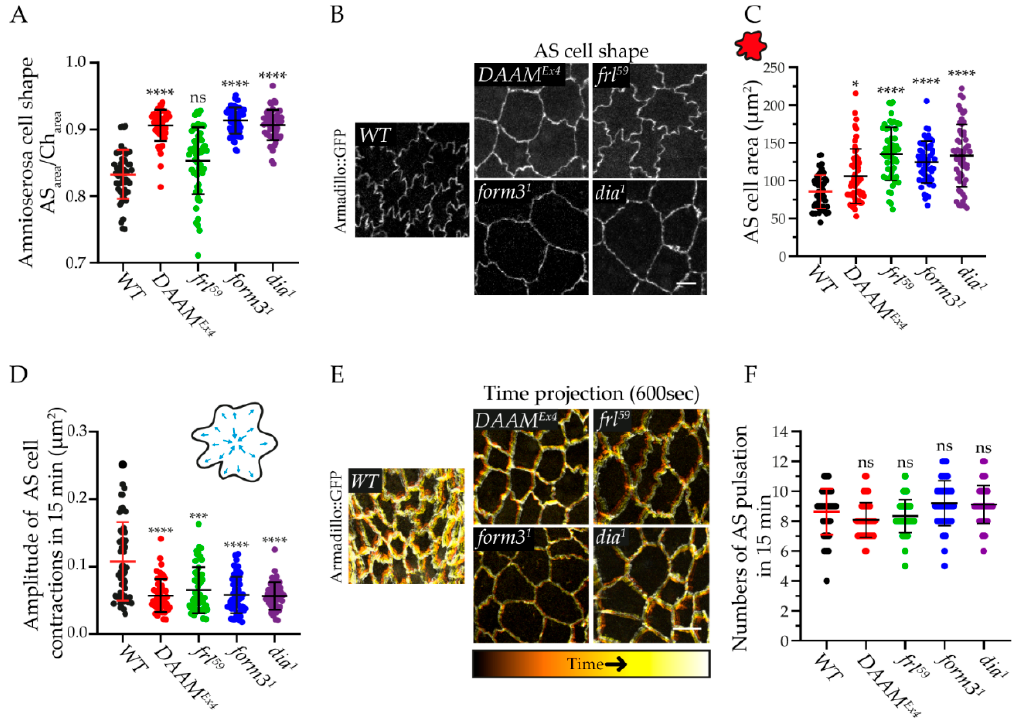
Figure 6. Loss of formins affects the dynamic parameters of the AS cells. Arm::GFP was used as wild type (WT) control. ( A ) Scatter dot plot of AS cell shape quantification by determining the ratio of AS area and the area of the fitted convex hull (Ch) in formin mutant embryos. ( B ) Representative images of the AS cell shapes. WT and frl 59 embryos show a wavy AS cell border, while the other mutants show a stretched cell border. Scale bar 5 µm. ( C ) Scatter dot plot of the AS cell area in formin mutants when the dorsal hole is 50 µm wide. ( D ) Scatter dot plot of the amplitude of AS cell contractions in formin mutants, measured in a 15 min time window. ( E ) Representative time projections of the AS cell contractions observed in the formin mutants. The width of the line at the cell cortex is proportional to the degree of contractions. Scale bar 10 µm. ( F ) Scatter dot plot of the number of AS cell pulsations during a 15 min time window. Note that the DAAM Ex4 and frl 59 embryos show a slightly decreased pulsation activity, while the form3 1 and dia 1 mutants show a slightly increased pulsation activity. Data sets were analyzed by Kruskal–Wallis tests p < 0.0001, followed by Dunn’s multiple comparisons test ( A , C , D ) and ordinary one-way ANOVA p < 0.0001, followed by Dunnett’s multiple comparisons test ( F ). Mutants were compared to the WT. Data are presented as mean ± SD; ns = non-significant. * p ≤ 0.05, *** p ≤ 0.001, **** p ≤ 0.0001.